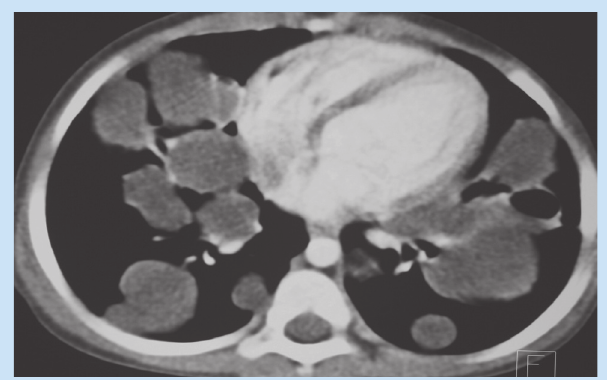
Fig. 2. Axial CT scan of the chest. The cystic nature of the pulmonary lesions can be appreciated.